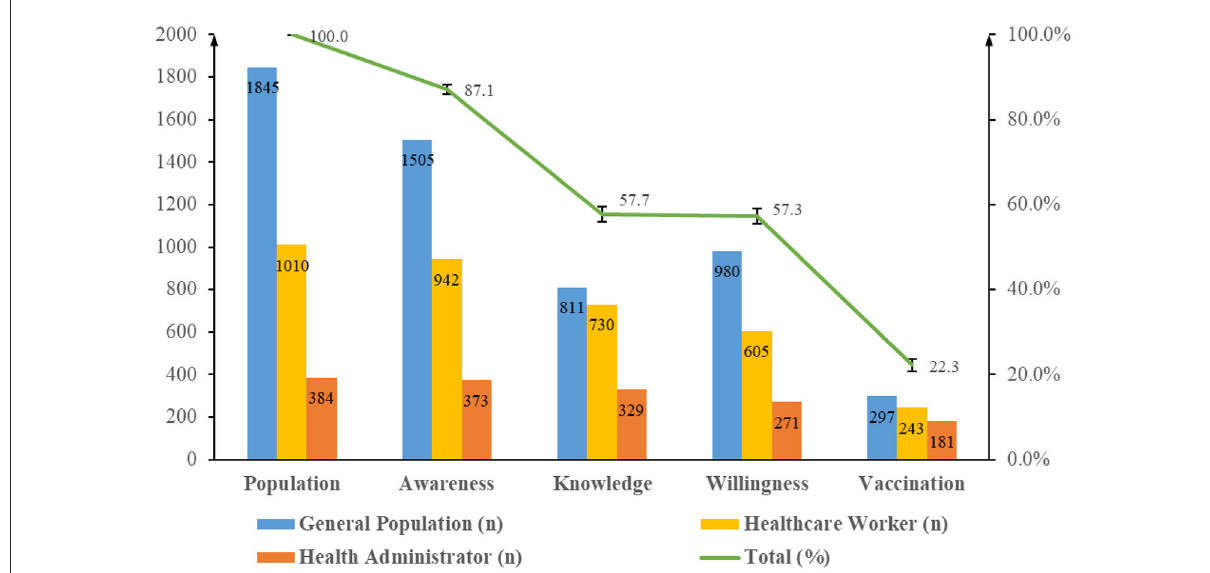
FIGURE1 Gaps in awareness, knowledge, willingness, and vaccination behavior toward influenza vaccine. The numbers of awareness, knowledge, willingness, and 5-year vaccination rate among general population, healthcare worker, and health administrator groups was calculated and shown in the graph. Rates of awareness, knowledge, willingness, and 5-year vaccination rate in all respondents was calculated and shown by the broken line.